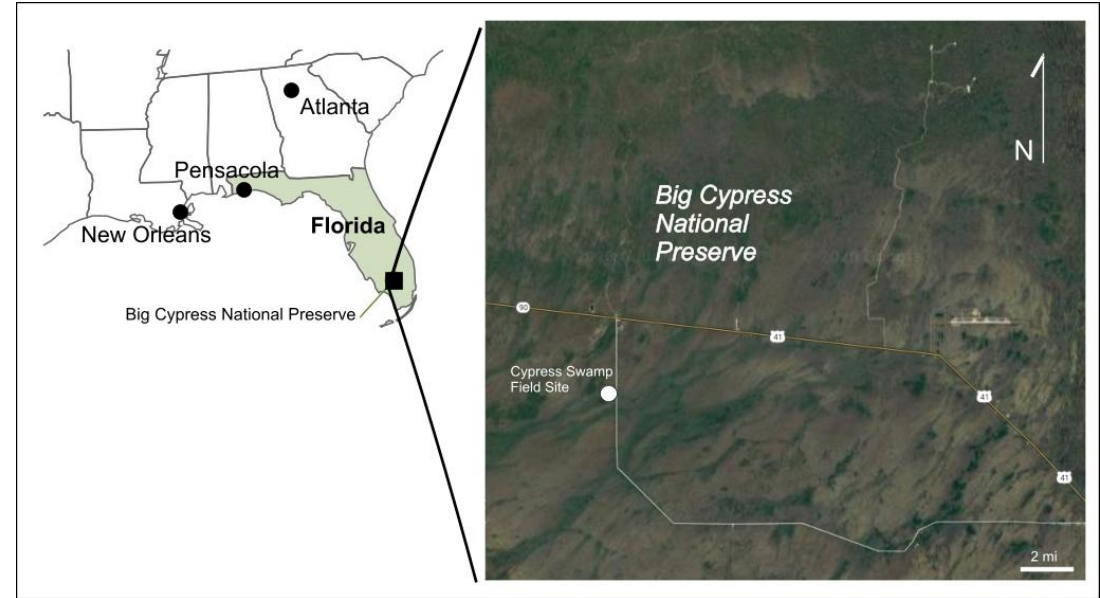
Figure 2. Site of field experiment.